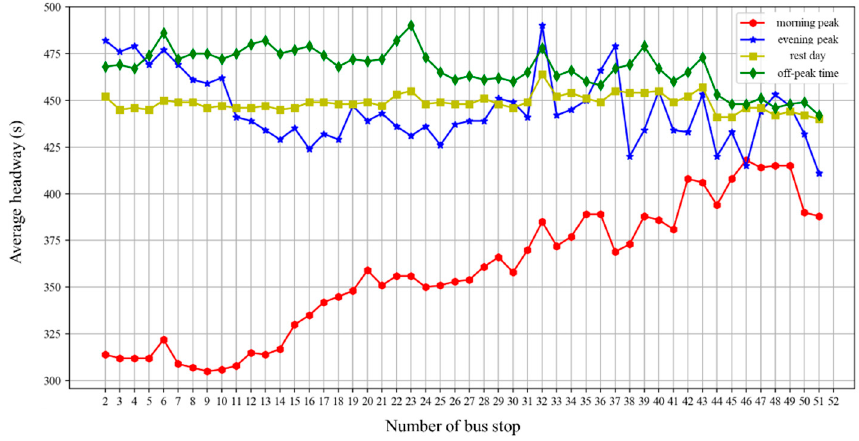
Figure 6. Average headway at bus stops in different time types.